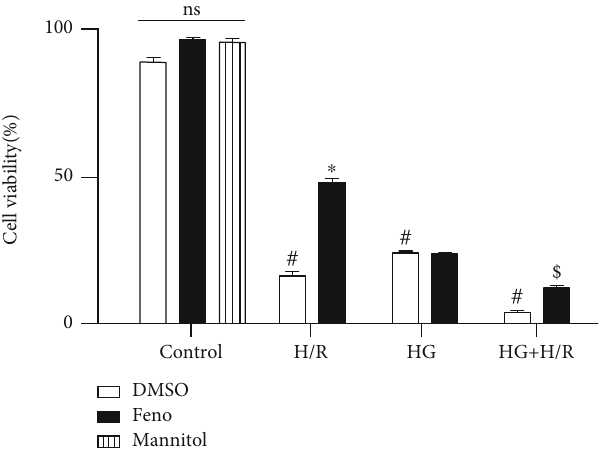
Figure 3: E ff ect of feno fi brate (10 μ M) on cell viability. Cell viability was assessed by a trypan blue dye exclusion test of control, hypoxia/reperfusion (H/R), glucose (HG), or the combination of conditions (HG+H/R) in primary culture of cardiomyocytes. DMSO = dimethylsulfoxide (0.1%); Feno = feno fi brate (10 μ M). # p < 0 : 05 vs. control-DMSO; ∗ p < 0 : 05 vs. H/R-DMSO; $ p < 0 : 05 vs. HG+H/R-DMSO. Values represent the mean ± SEM of 6 di ff erent experiments. Two-way analysis of variance (ANOVA) followed by Tukey ’ s post hoc